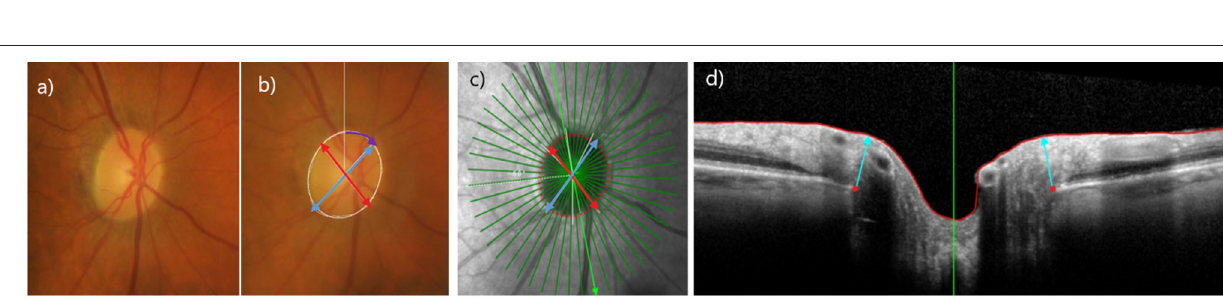
FIGURE 2 | Ovality and Rotation angle measurements on photographs and OCT. (a) Stereophotograph of a healthy eye, (b) clinical disc margin annotated in white, labeled with major axis (blue), minor axis (red), rotation angle (purple); Ovality index (minor axis/major axis), (c) en-face OCT optic nerve head image of Bruch’s Membrane Opening (BMO) (red); Ovality index (minor axis (red)/major axis (blue). Please note as described previously, the calculations use the 3D OCT scan. ( 21) (d) b-scan of optic nerve head with BMO points in